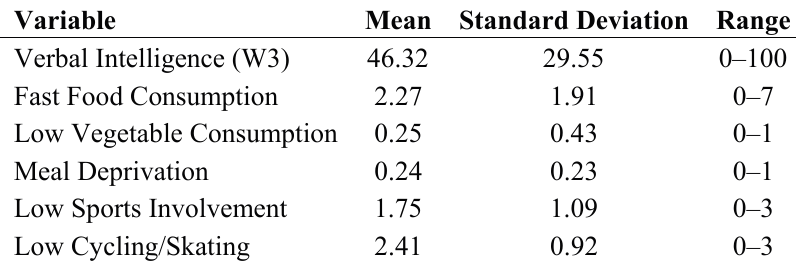
Table 1. Descriptive statistics of the MZ and same-sex DZ twin